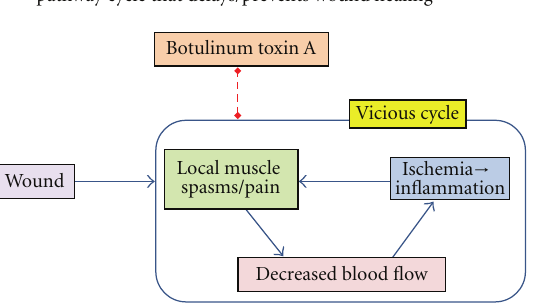
Figure 2: Botulinum toxin is depicted to disrupt the vicious pathway cycle that delays or prevents the healing of moderate wounds. This cycle involving spasm, pain, diminished blood flow, ischemia, and inflammation is blocked by the inhibition of chemical transmission at neuromuscular junctions by botulinum toxin A [29, 42, 43]. Dashed line is inhibitory action.